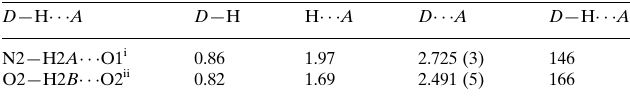
Hydrogen-bond geometry (A˚ , (cid:3)